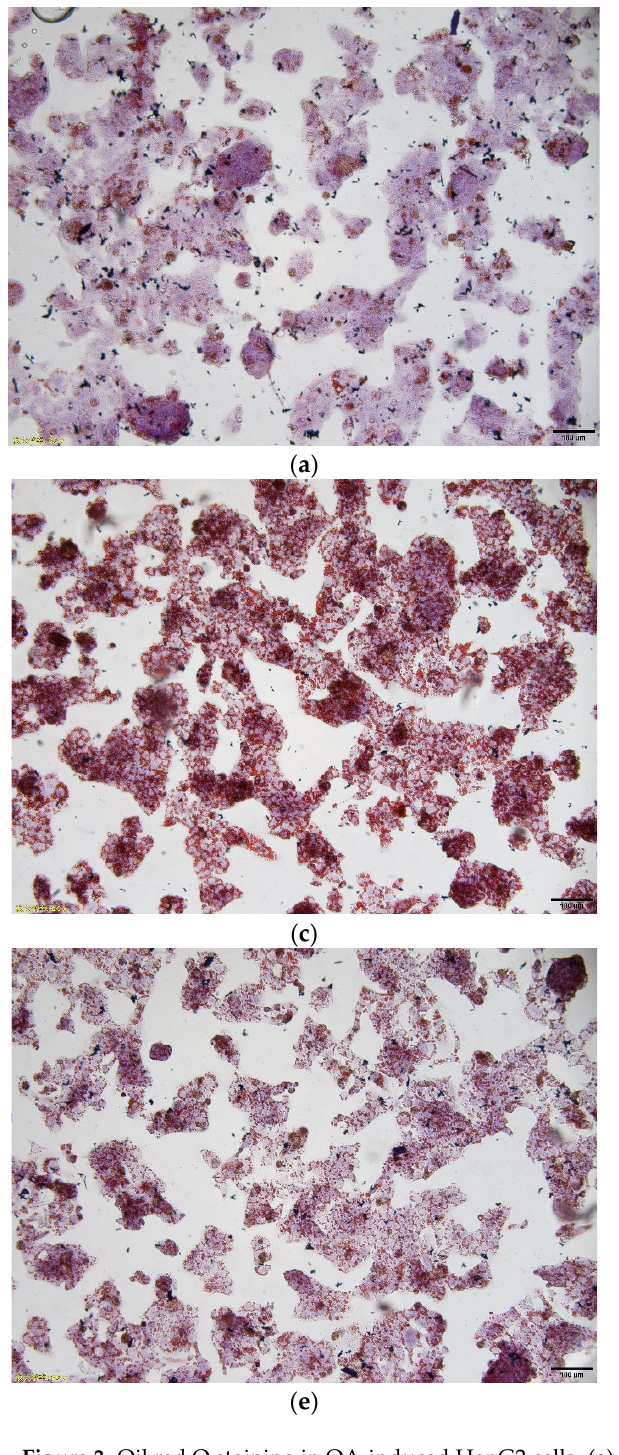
Figure 3. Oil red O staining in OA-induced HepG2 cells. ( a ) NC group (HepG2 cells); ( b ) OA group (0.2 mM OA-induced HepG2 cells); ( c ) LIOP group (0.2 mM OA + 20mg/L IOP); ( d ) MIOP group (0.2 mM OA+40mg/L IOP); and ( e ) HIOP group (0.2 mM OA + 60mg/L IOP). Bars × 400.